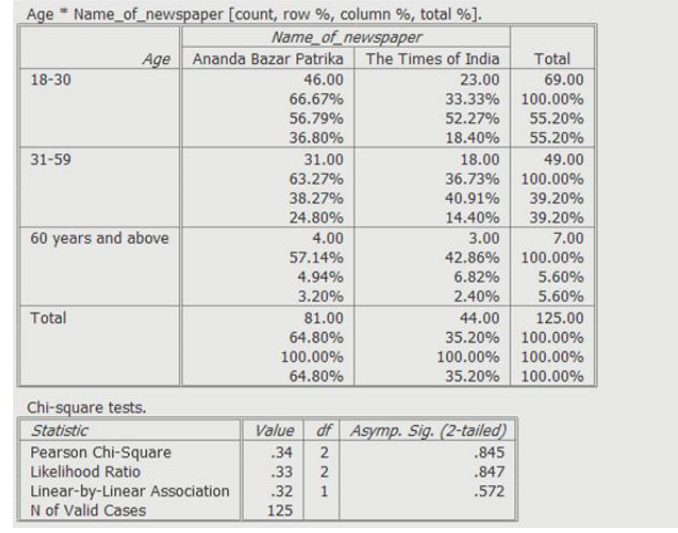
Figure 5: Cross tabulation and Chi-square between Gender v/s Newspaper Read (Source: Authors‟ depiction) According to this Chi-square test p-value > 0.05, we can say age has a significant effect on newspaper read at a level of 5% significance.